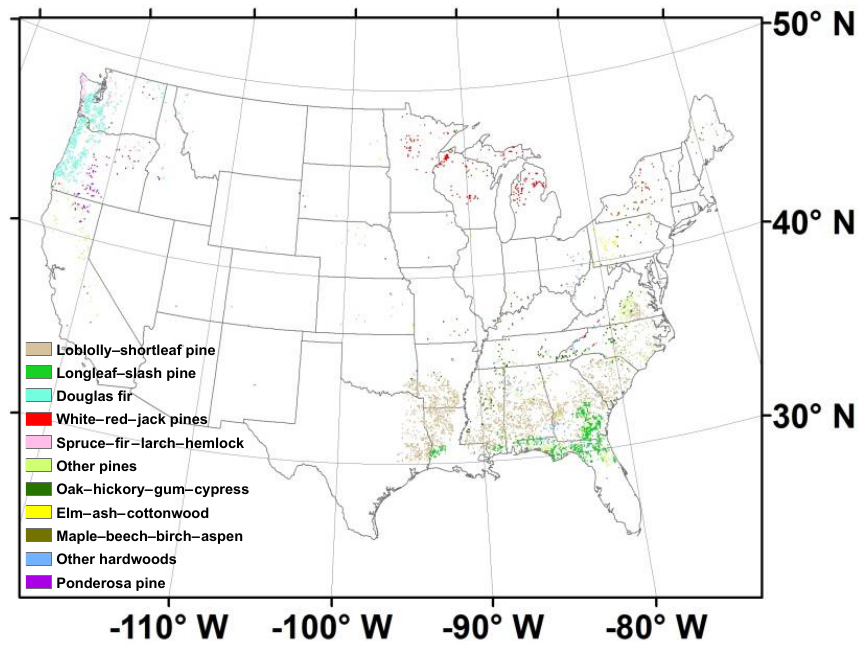
Figure 11. Spatial distribution of plantation tree species in the CONUS in 2012.